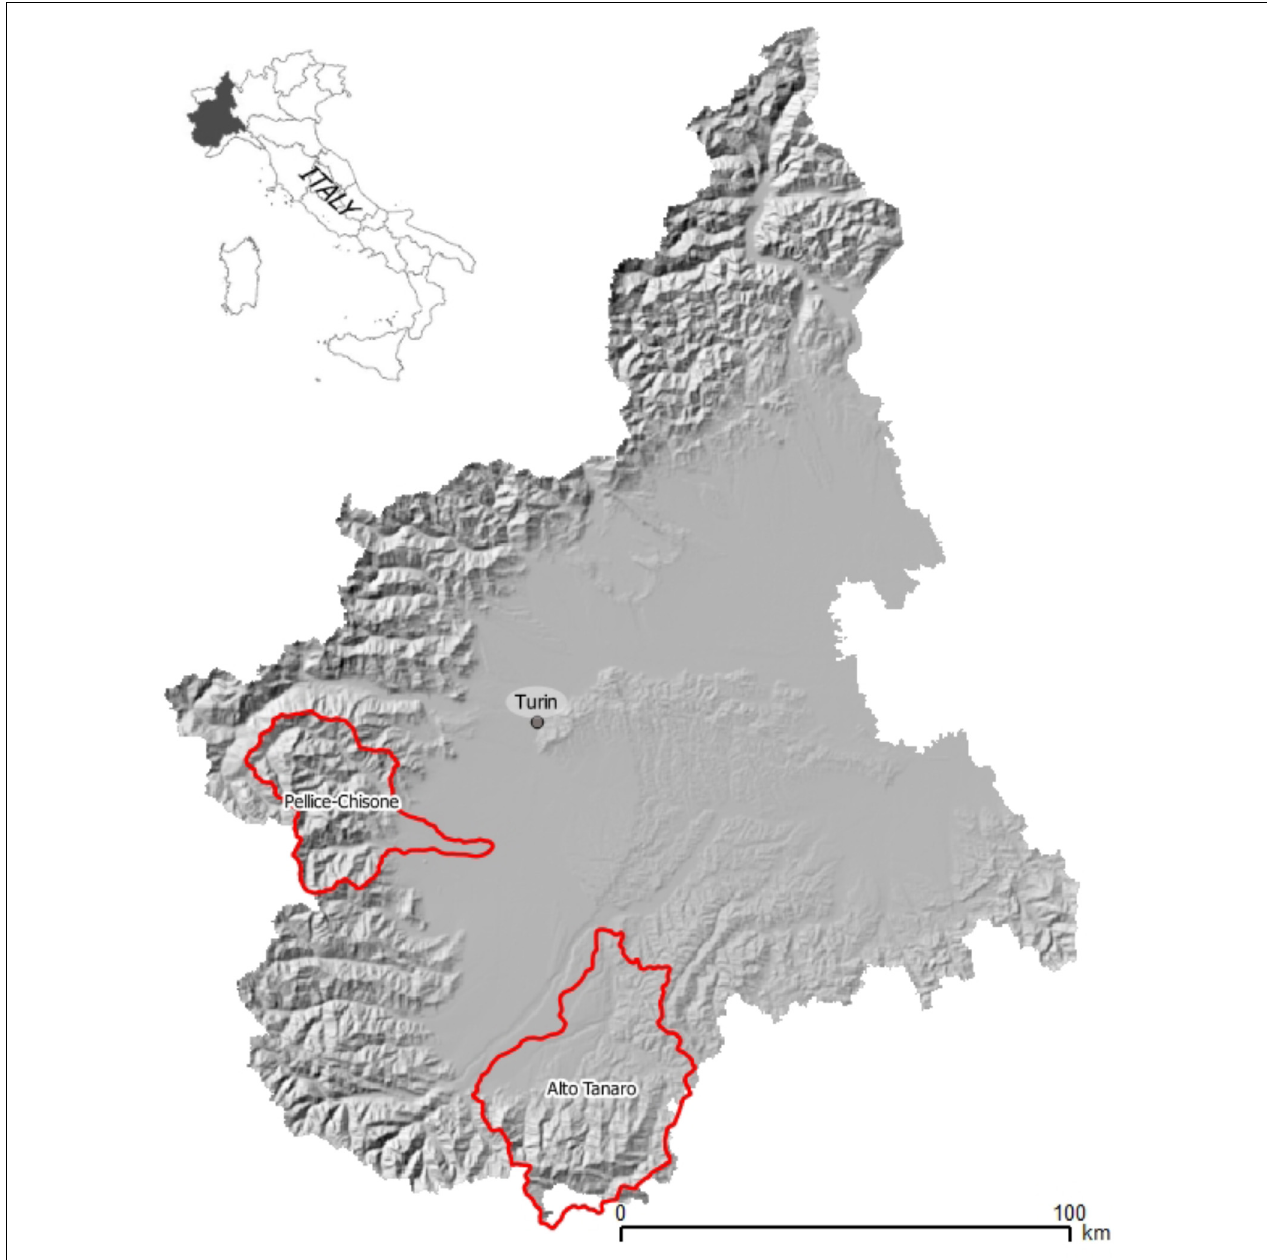
FIGURE 1 | Identified study areas (bordered in